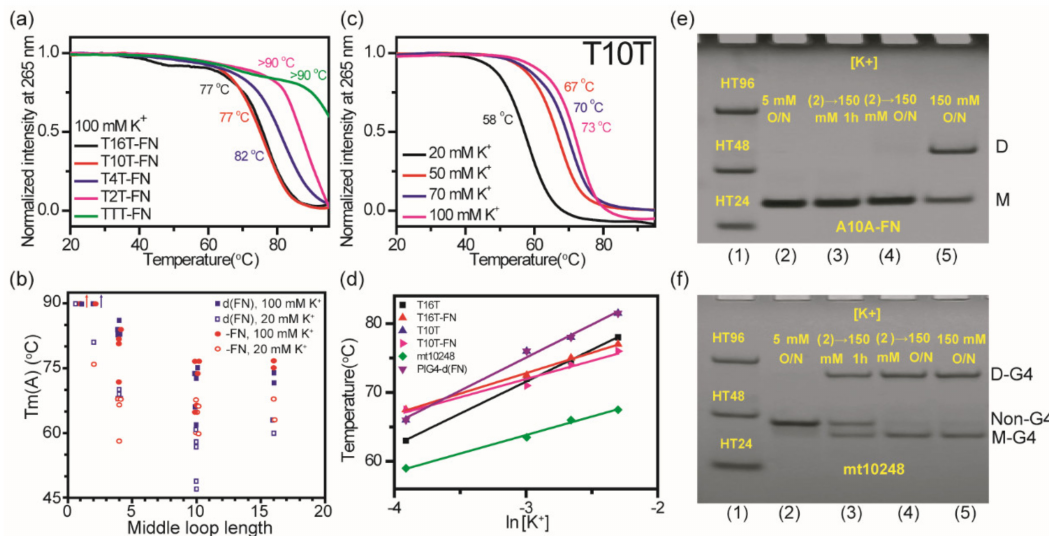
Figure 8. The e ff ect of K + concentration on thermal stability of (G 3 HG 3 N m G 3 HG 3 ) G4 structures. ( a ) CD melting curves of T16T-FN, T10T-FN, T4T-FN T2T-FN, and TTT-FN after the addition of 100 mM K + overnight. ( b ) The plots of Tm(A) as a function of middle loop length of both (G 3 TG 3 N m G 3 TG 3 ) and (G 3 TG 3 N m G 3 TG 3 )-FN sequences after the addition of 20 mM K + and 100 mM K + overnight. ( c ) CD melting curves of T10T after the addition of 20, 50, 70, and 100 mM K + overnight. ( d ) The plots of Tm(A) of T16T, T16T-FN, T10T, T10T-FN, PIG4-d(FN), and mt10248 measured from CD melting as a function of ln[K + ] with linear regression fits. ( e ) PAGE assays of marker bands of HT24 (T 2 AG 3 ) 4 , HT48 (T 2 AG 3 ) 8 , and HT96 (T 2 AG 3 ) 16 (lane 1) and A10A-FN after the addition of 5 mM K +